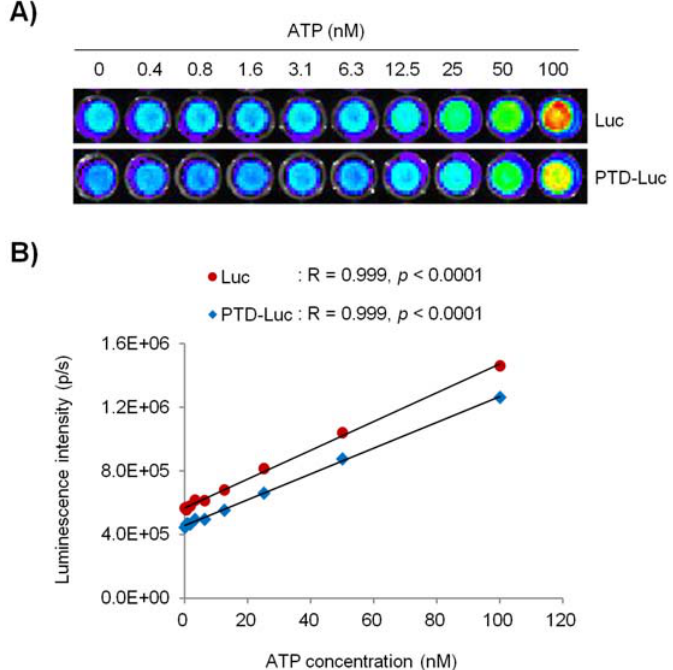
Figure 3. Effect of PTD conjugation on the in vitro ATP assay ( A ) Representative luminescence images. PTD-Luc (40 pM) or Luc (10 pM) was incubated with luciferin substrate solution with the indicated concentrations of ATP. ( B ) The correlation between the luminescence intensity (p/s, y -axis) and ATP concentration (nM, x -axis) is plotted. Symbols represent mean values, and lines represent the linear data fit. Pearson’s correlation coefficient (R) is shown above the